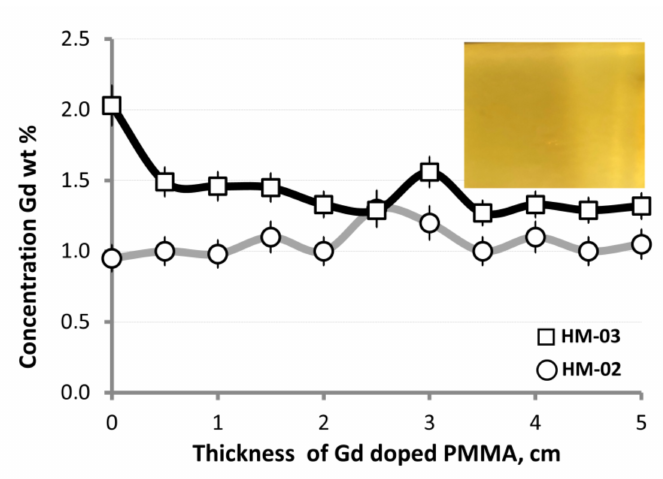
Figure 8. Gd distribution along the HM width determined by EDAX analysis.